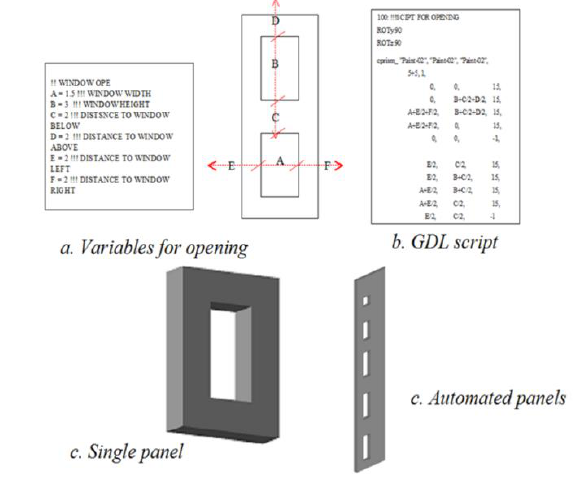
Figure 4. Wall panel Sample GDL Script